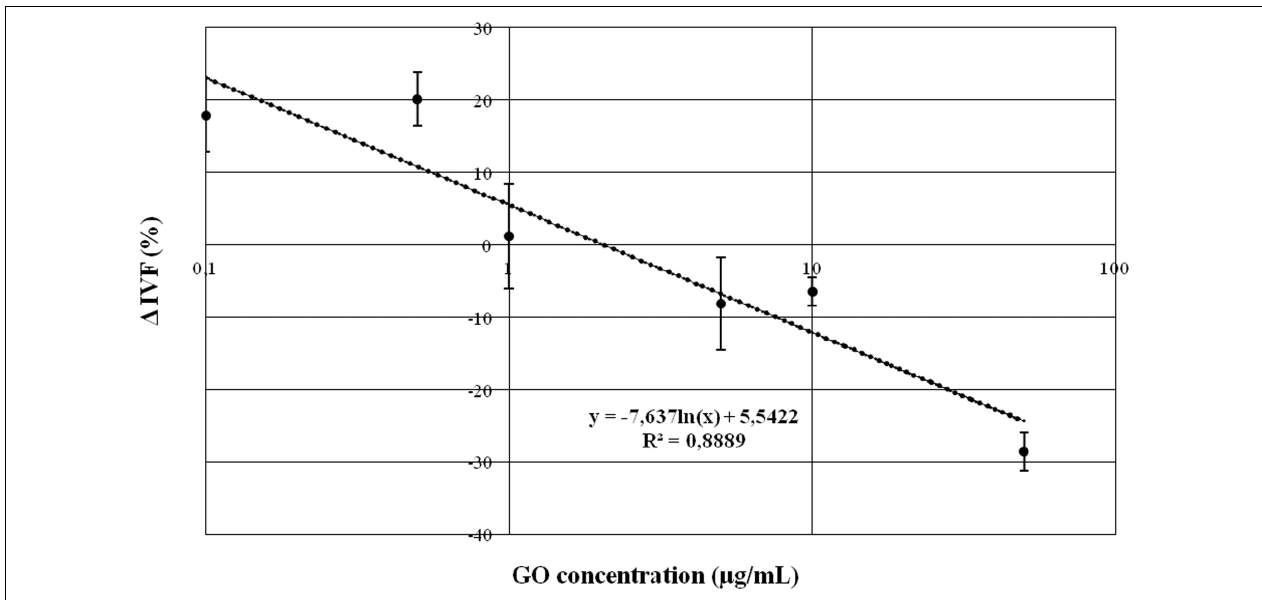
FIGURE 2 | Graph representing the relationship between GO concentration and IVF outcomes, expressed as difference in percentage ( (cid:49) IVF%) respect to the CRTL.